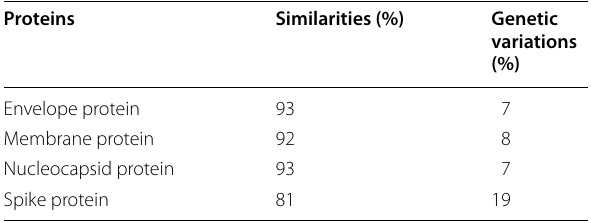
Table 1 Protein variations and similarities between SARS-CoV and SARS-CoV-2 (Rehman et al.